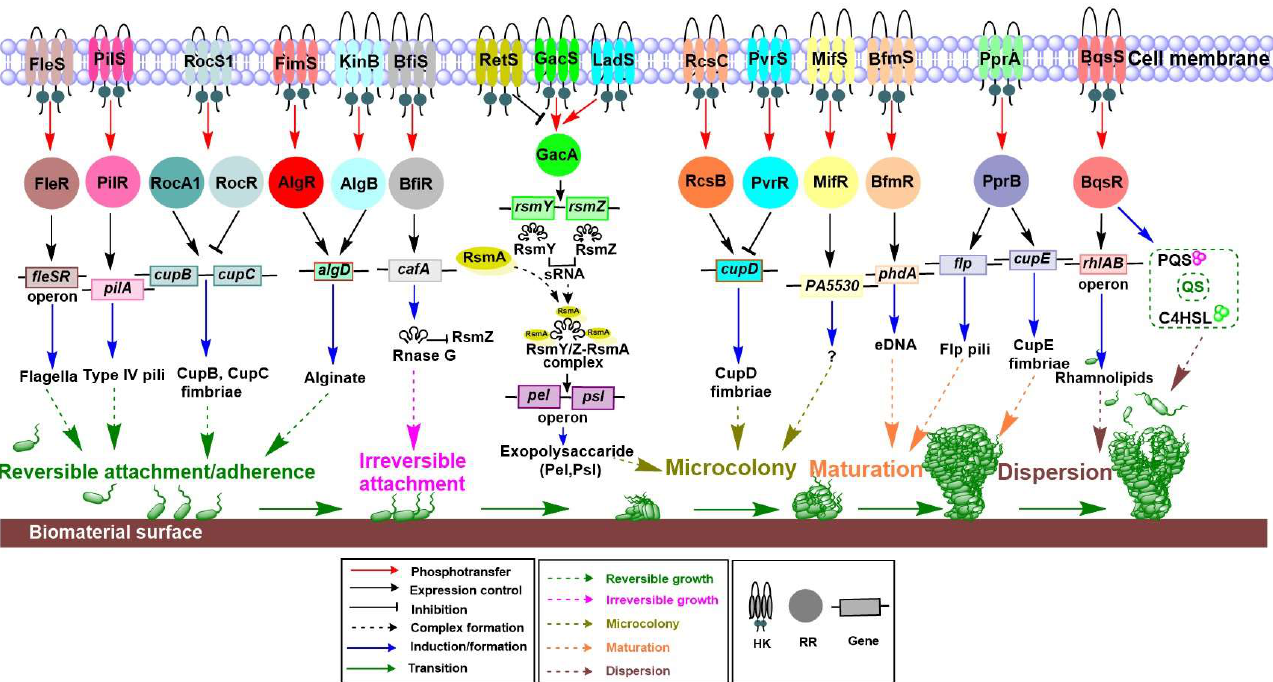
Figure 3. The role of TCSs in biofilm formation. Important stages of P. aeruginosa biofilm formation are reversible attachment/adherence, irreversible attachment, microcolony formation, maturation, and dispersion. Many TCS are important for initial adherence. FleSR and PilSR are responsible for flagella and pili motility structures during initial attachment. RocS1-RocR and RocA1 play a role in production of the CupB and CupC fimbriae structure. FimS-AlgR and KinB-AlgB are responsible for alginate biosynthesis and help with adherence. During the initial stages, BfiSR has a role in irreversible growth. The GacSA acts in a parallel and antagonistic manner to LadS and RetS. The free RsmA regulatory proteins, together with sRNAs (RsmY and RsmZ) lead to the complex formation of RsmY/RsmZ-RsmA and play a role in the production of exopolysaccharides Pel and Psl. RcsCB and PvrSR are important for the CupD fimbriae structure. BfmSR and MifSR are essential for regulating microcolony formation and initial maturation during biofilm formation. PprAB is crucial for the CupE fimbriae structure and helps microcolonies to form and mature. BqsSR plays a role in the production of rhamnolipids and is responsible for dispersion of biofilm.